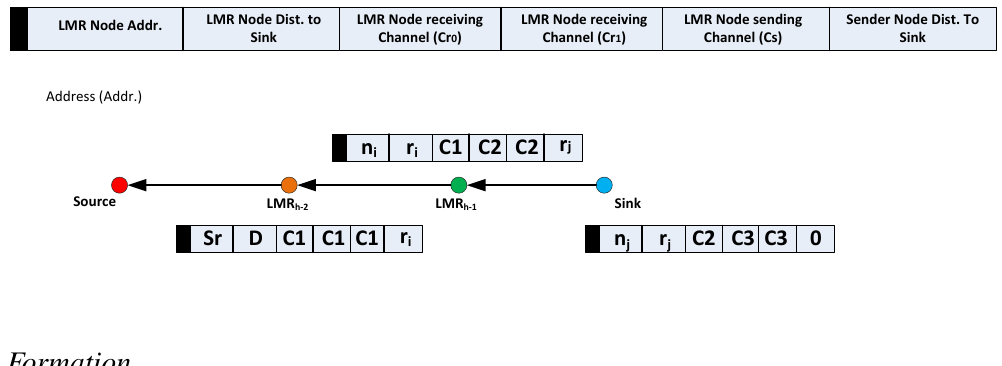
Figure 3. Virtual contention group (VCG) formation operation with payload. LMR, local minimum